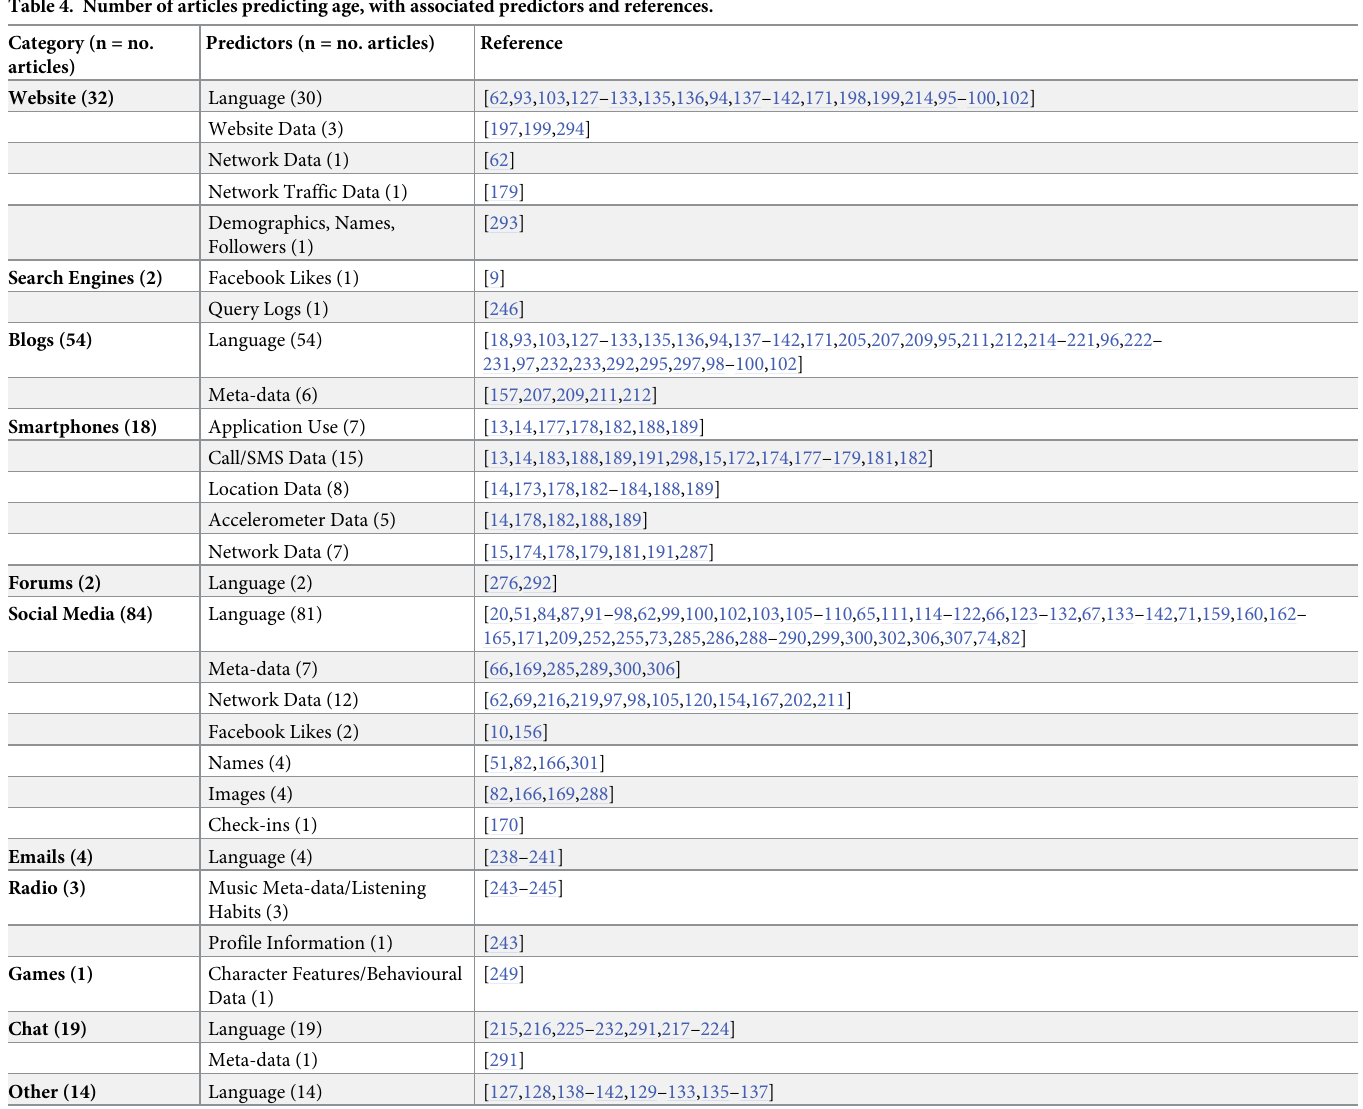
Table 4. Number of articles predicting age, with associated predictors and references. Category (n = no.